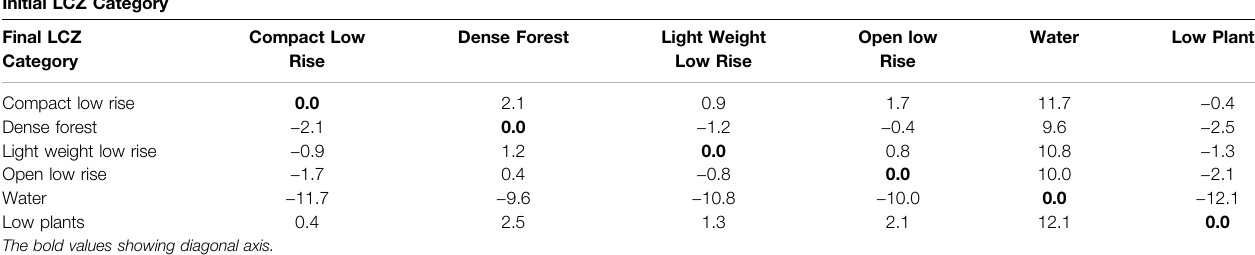
TABLE 5 | Responses of LST to LCZ transitions corrected for background